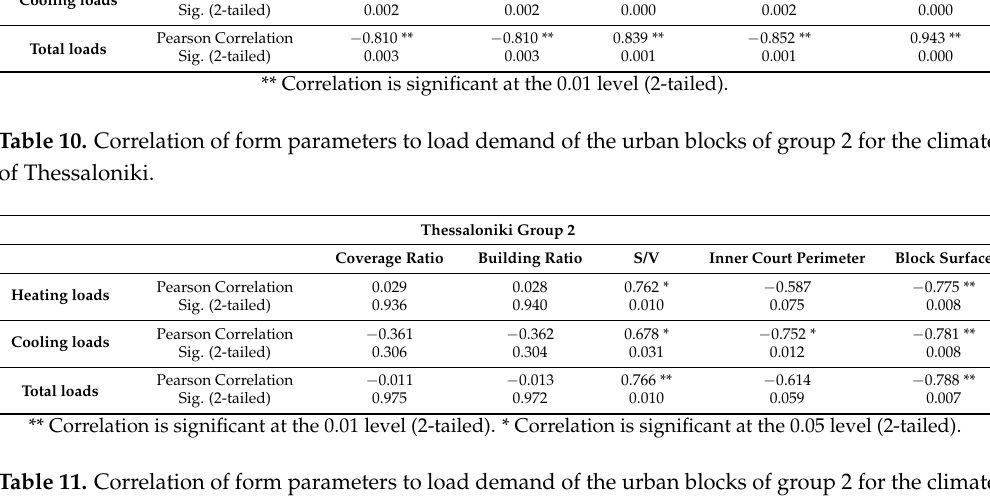
Table 11. Correlation of form parameters to load demand of the urban blocks of group 2 for the climate of Heraklion.